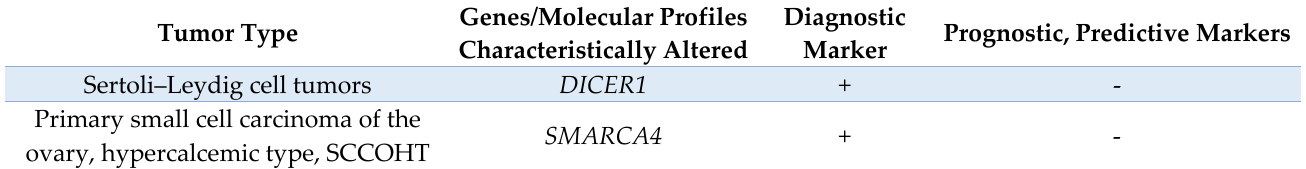
Table 9. Molecular markers—ovarian cancers.